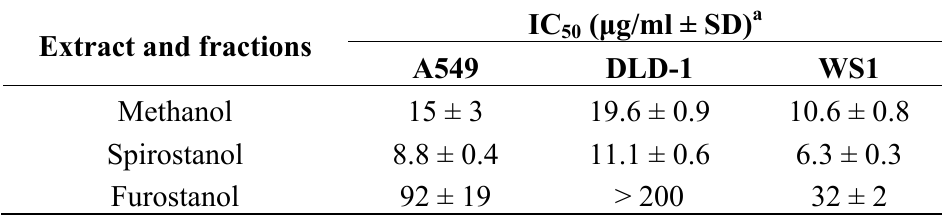
Table 1. Cytotoxicity of extract and saponin fractions from A.